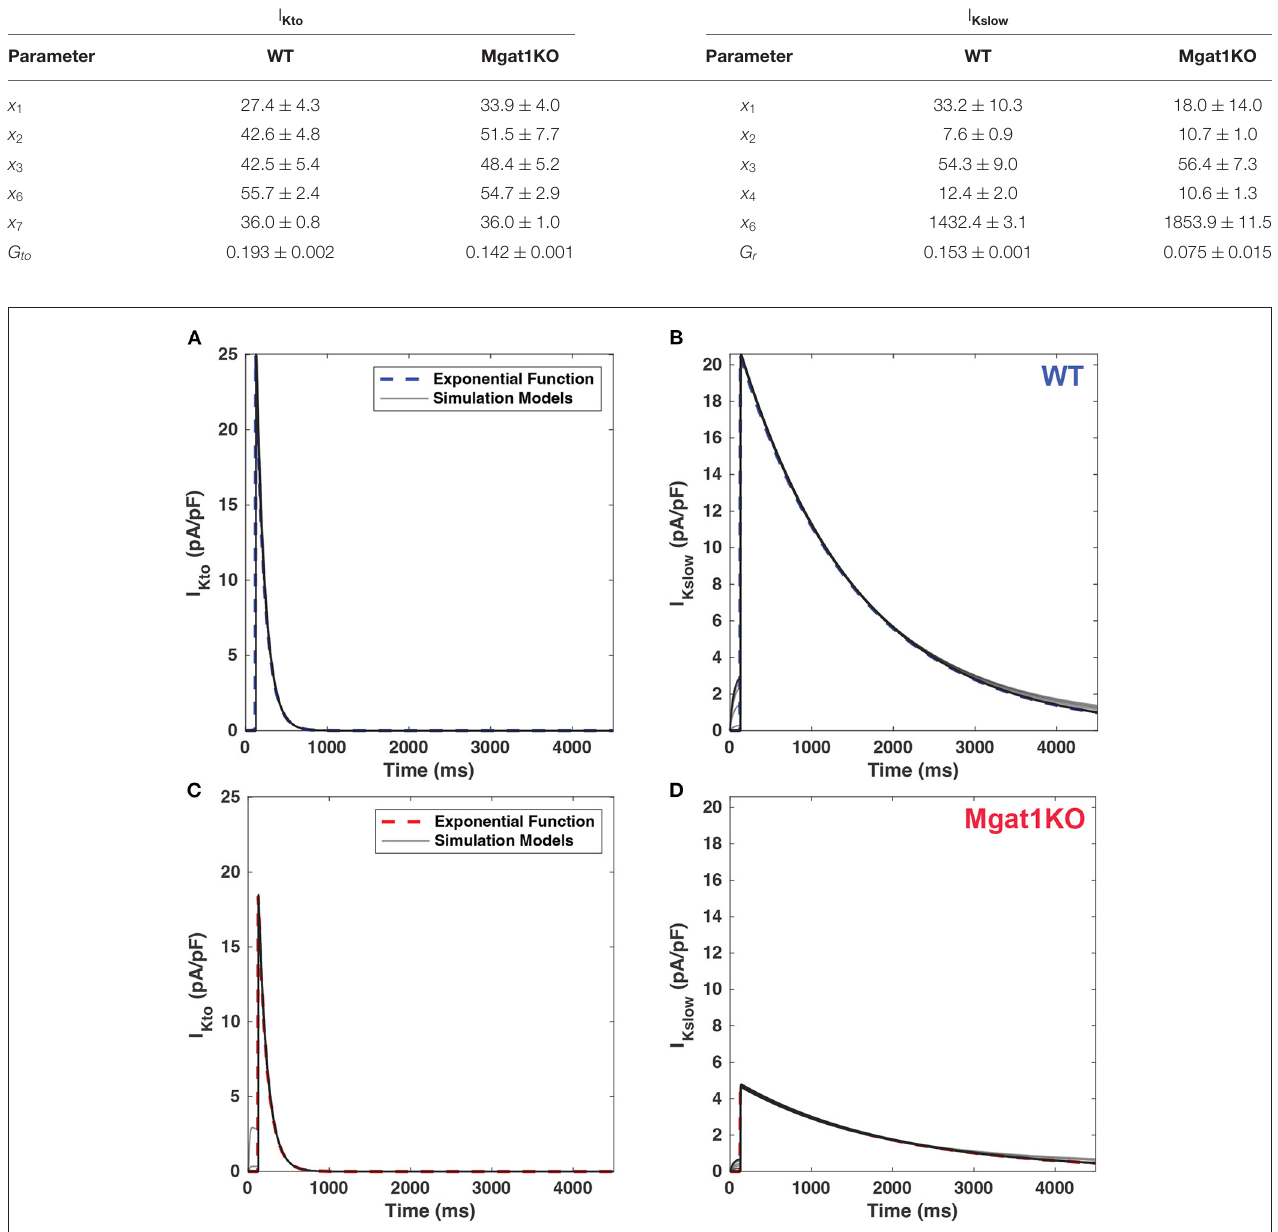
TABLE 1 | Calibrated model parameters.